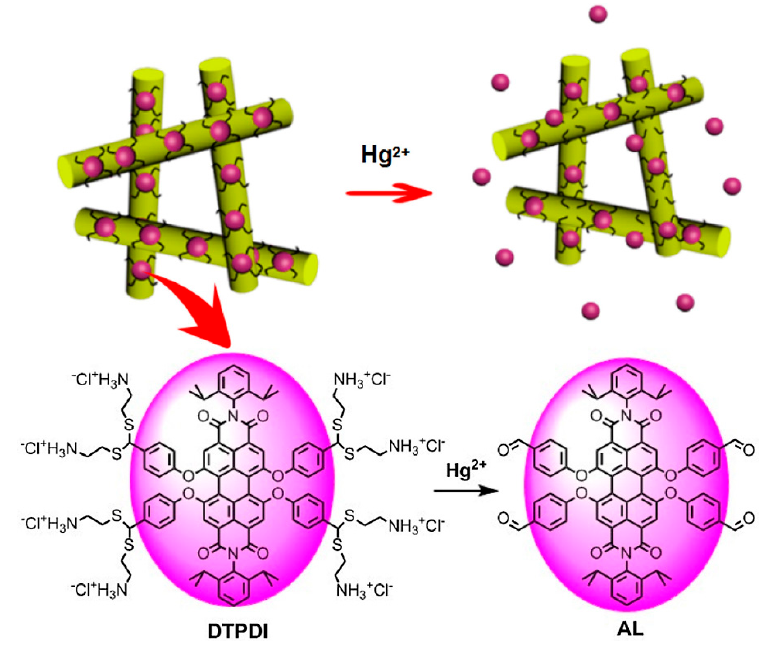
Figure 9. Schematic illustration for the sensing of Hg 2+ by a fluorescent nanofibrous membrane (FNFM). Reprinted with permission from [52]. Copyright 2017, Elsevier.